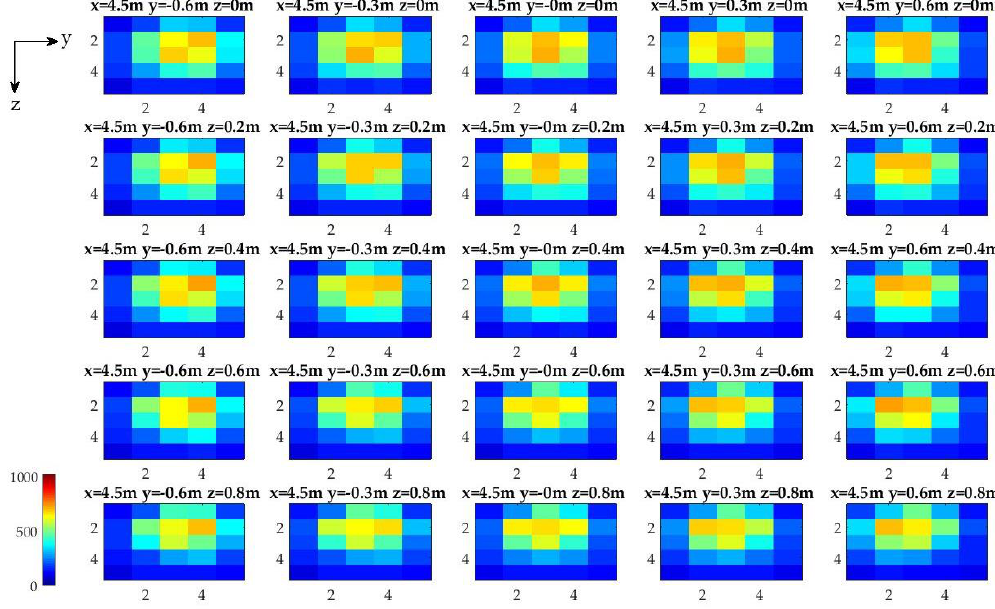
Figure 4. Sample underwater experimental calibration images taken at 4.5 m away from the light source in the x -direction. The intensity images (represented by a 10-bit dynamic range (0–1023)) represent the intersection of optical detector array system with the light field from the guiding beacon y - and z -axis at different y - and z -axis offsets.